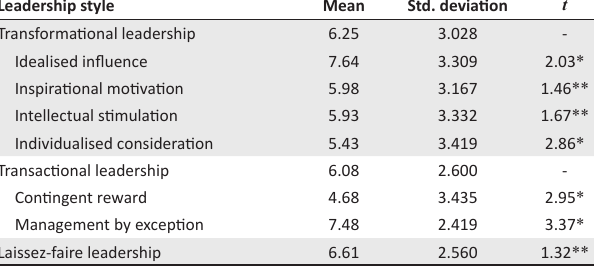
TABLE 4: Sub-construct means, standard deviations and t